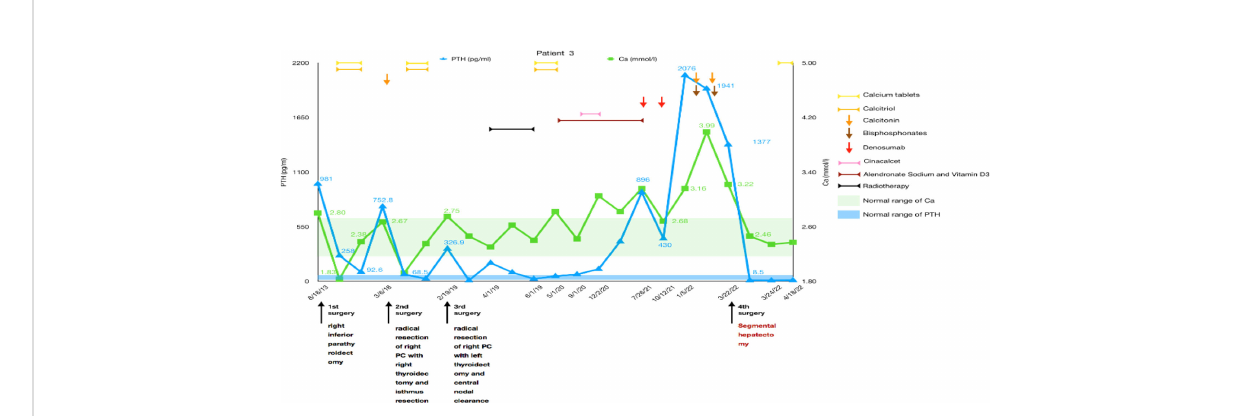
FIGURE 3 Summary of the clinical course, including changes in serum calcium and PTH of patient